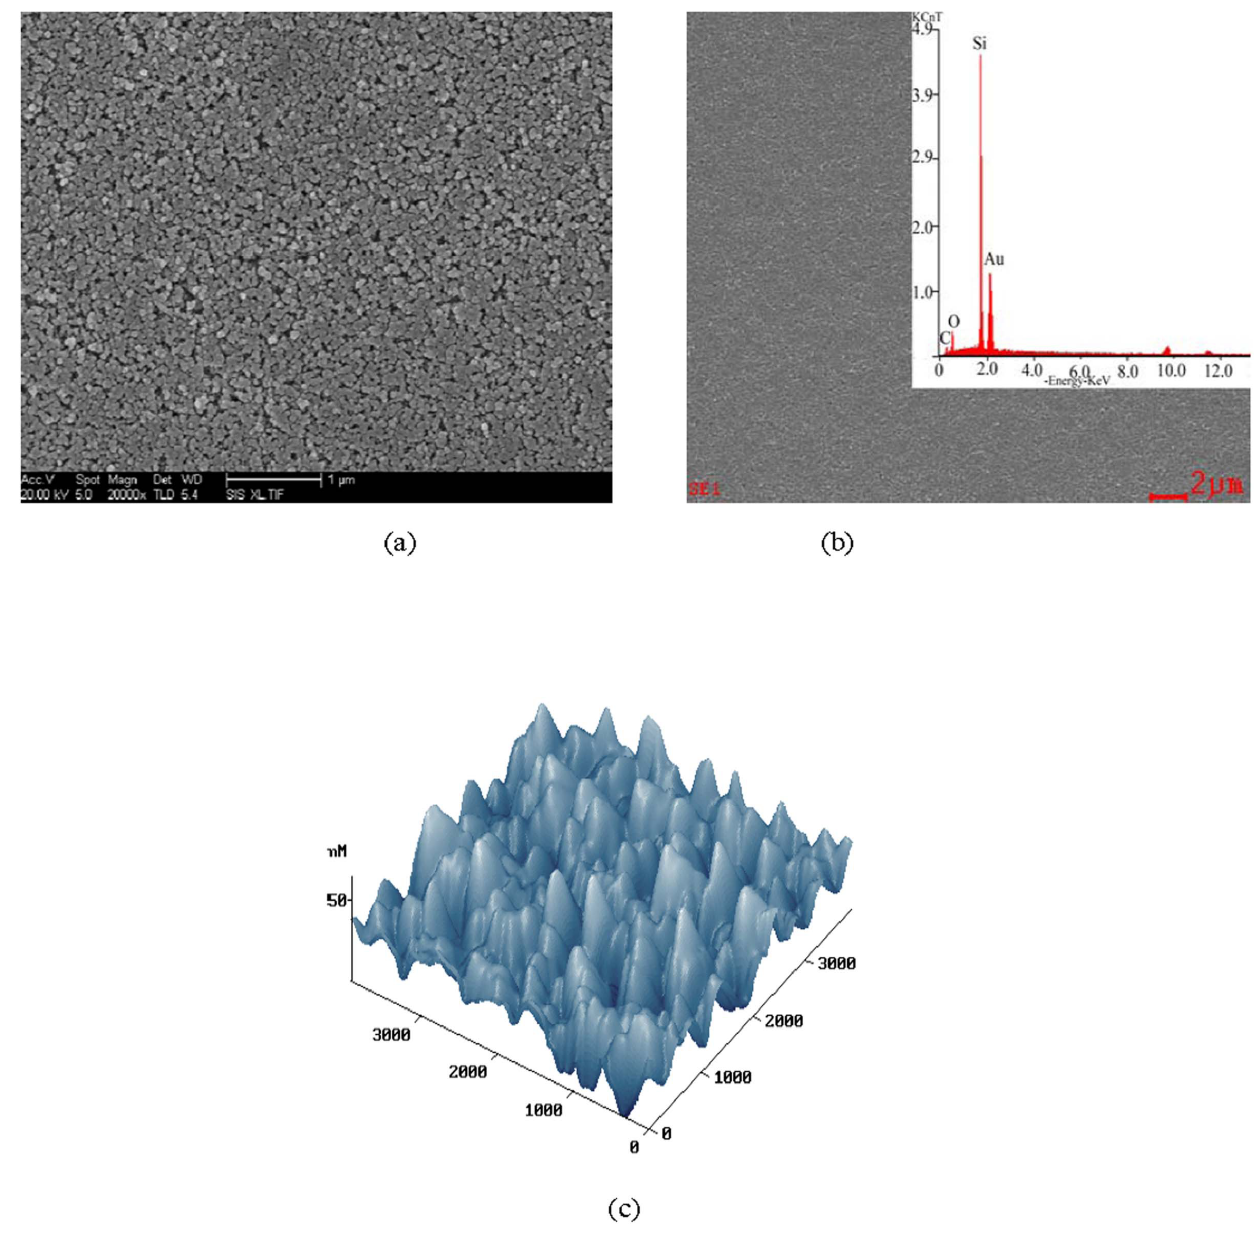
Figure 2. Structure and infiltration analysis of RC-IJP: (a) SEM (b) EDS (c) AFM. doi:10.1371/journal.pone.0109918.g002 PLOS ONE |